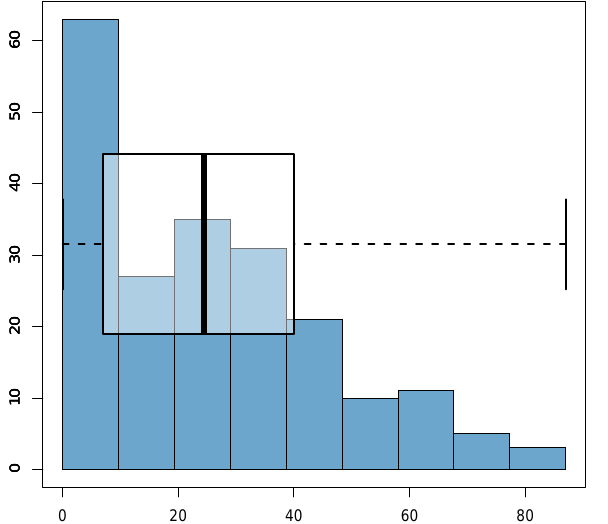
Figure 4. Boxplot and histogram of the oncological check-ups’ delays. Axis X : delay time in minutes. Axis Y : number of